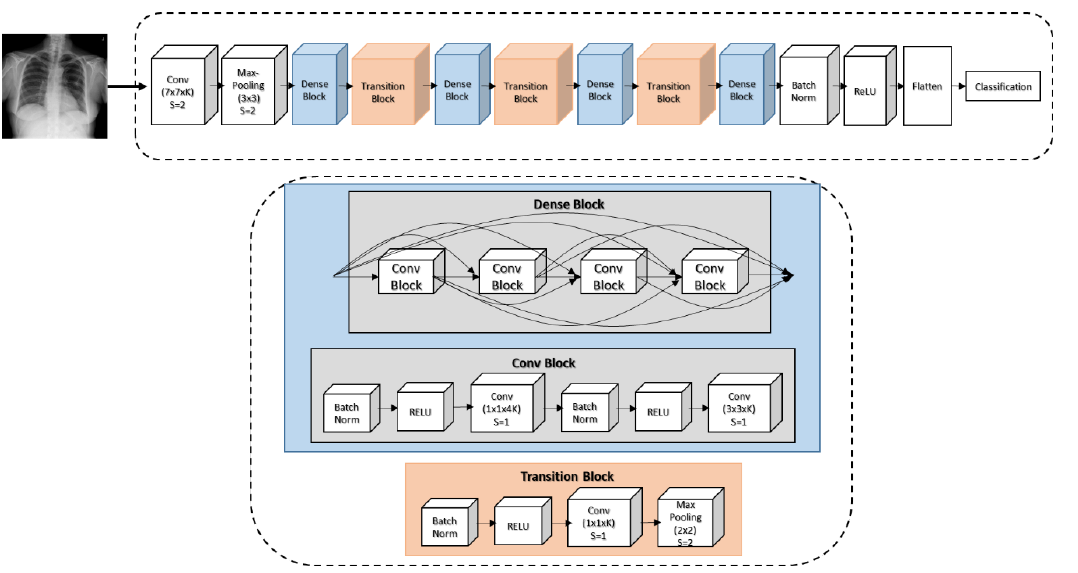
Figure 2. DenseNet-121 architecture for generating class activation map (CAM) results and classifying the 14 pathologies.